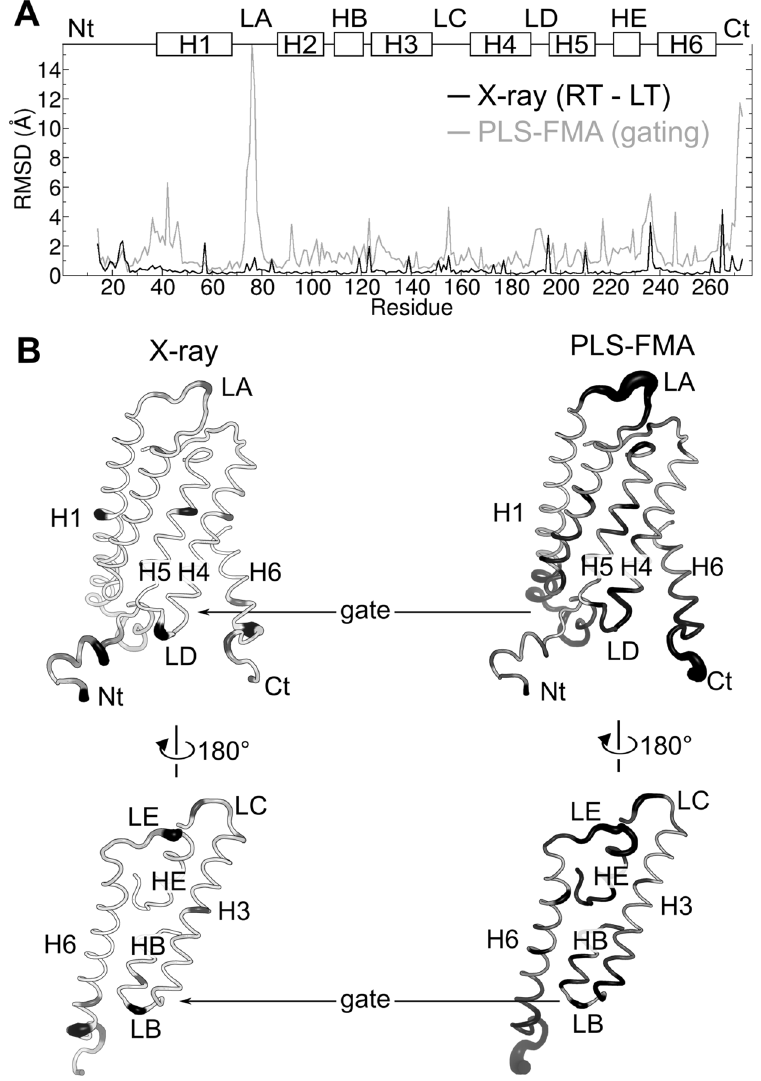
Figure 3. Structural differences between X-ray structures compared to gating motions of Aqy1. ( A ) Root mean square deviation (RMSD) as a function of the residue index is displayed. For the X-ray data, the RMSD quantifies the separation between the LT and RT structures (X-ray, black line). For the gating motion, which is induced by phosphorylation or membrane-mediated mechanical stress, the RMSD reflects the extent of the conformational changes during the opening motion, which was recovered by partial-least-square functional- mode-analysis (PLS-FMA, gray line). The secondary structure of the protein is displayed at the top, indicating helices (H1 to H6), half-helices (HB and HE), loops (LA to LD), and termini (Nt and Ct). See details of the RMSD calculations in the methods section. ( B ) Aqy1 monomer in cartoon-tube representation with the RMSD for each amino-acid encoded in the color and the size of the tube, ranging from RMSD = 0 (white and small) to RMSD > 2 Å (black and big). RMSD between the X-ray structures is shown at the left and RMSD associated to the gating transitions as revealed by PLS-FMA at the right. Two orientations are displayed for each case (not all secondary-structure elements are shown for